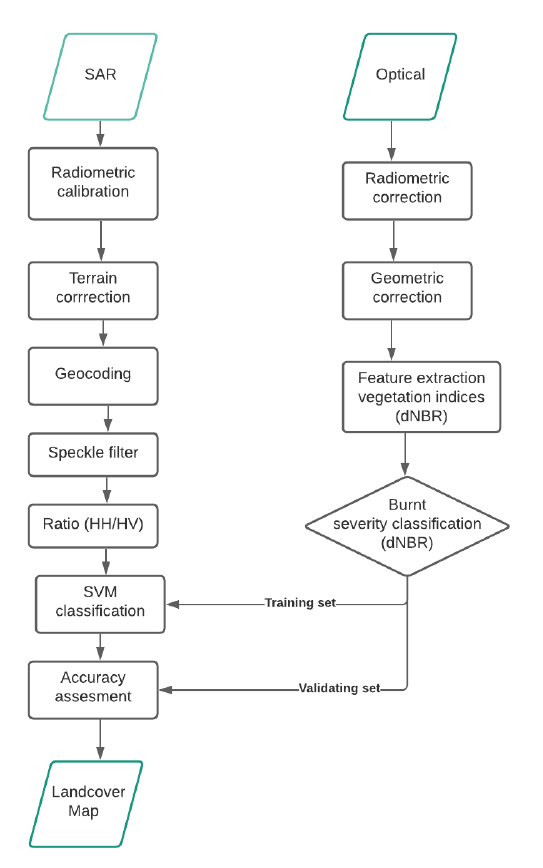
Figure 1. Processing